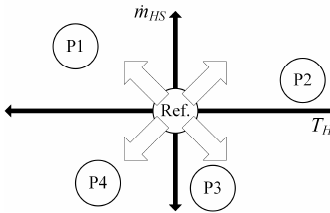
Figure 3. Approach of modular design: derive different plants P1 to P4 for various heat source temperatures and mass flow rates from one reference plant (Ref.).